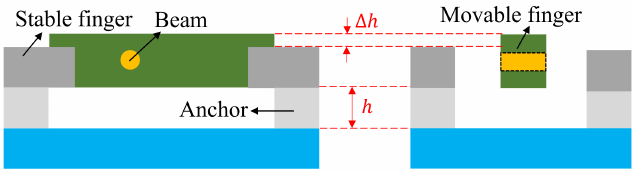
Figure 2. Front view of the comb finger and side view of the comb finger.